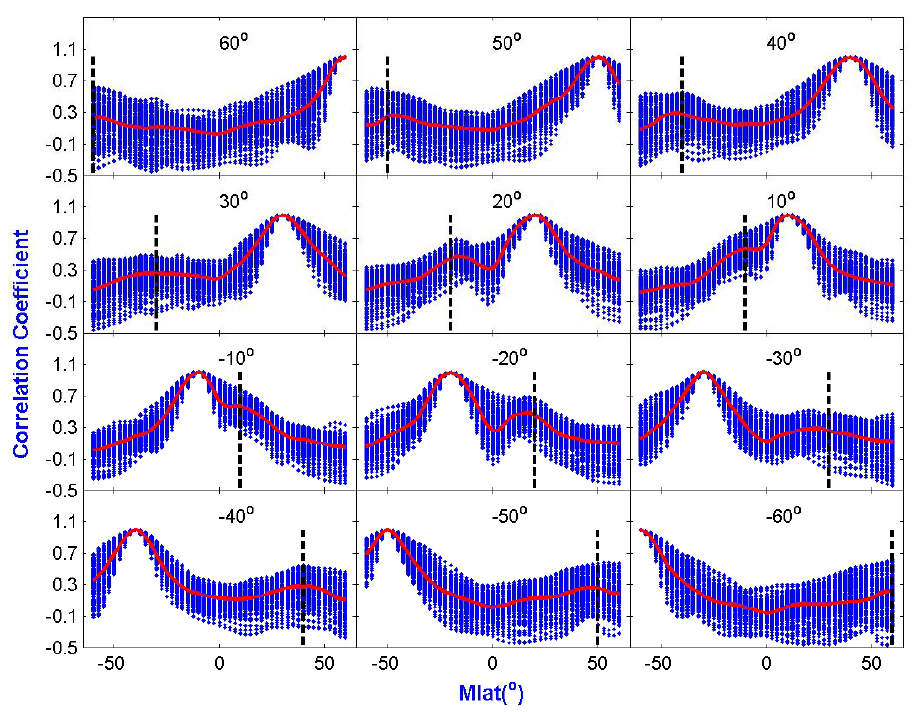
Fig. 2. (a) Correlation coefficients between one fixed apex latitude with all other apex latitudes from –60 ◦ to 60 ◦ . The number in every subplot is the corresponding apex latitude. The solid lines are mean values of different local time, month and year. The vertical dashed lines mark the corresponding magnetic conjugate latitude.